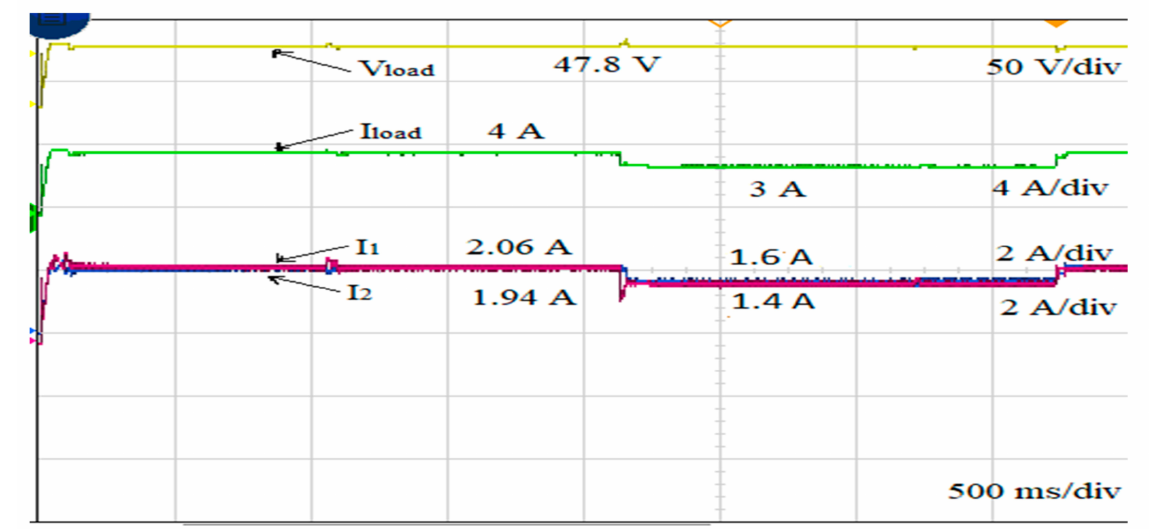
Figure 21. Experimental results for variation in source voltage and load with different cable resistances for proposed droop control.